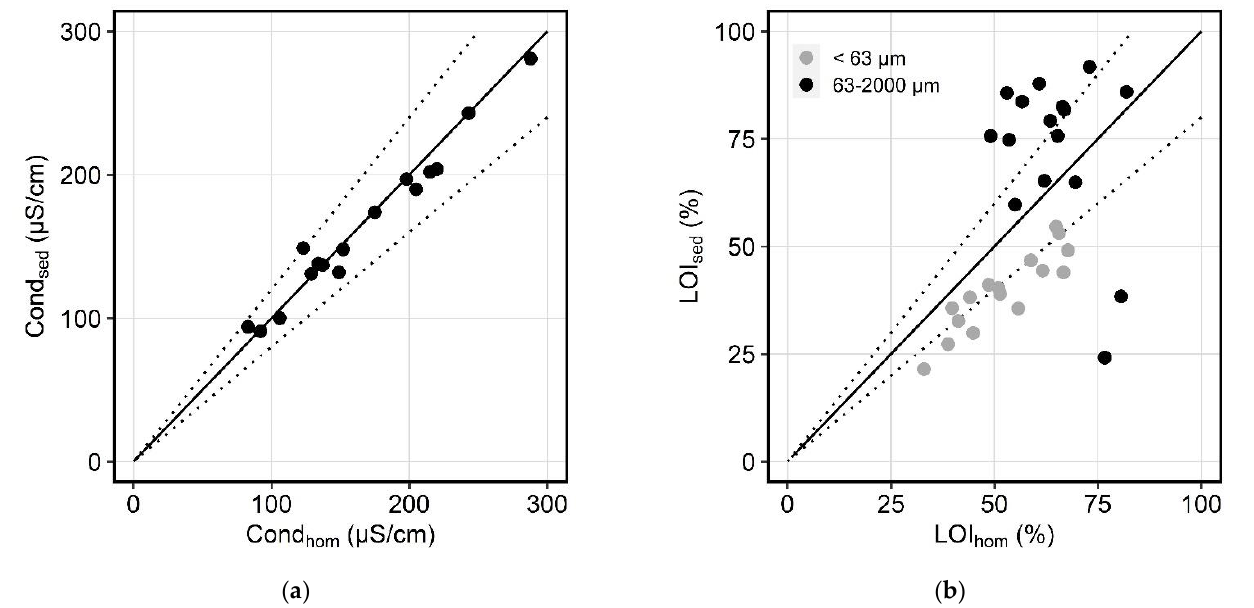
Figure 9. Scatterplots of conductivity (Cond) ( a ) and loss on ignition (LOI) ( b ) measured in homogenized (hom) and sedimented (sed) large-volume samplers samples. Dotted lines show 20% deviation.